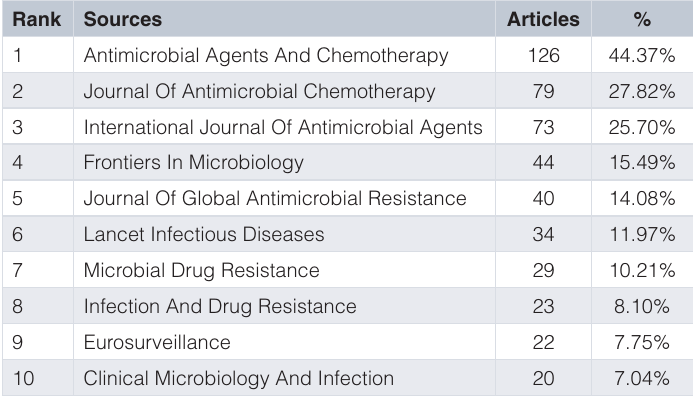
Table 2. The top 10 sources that published articles in colistin resistance